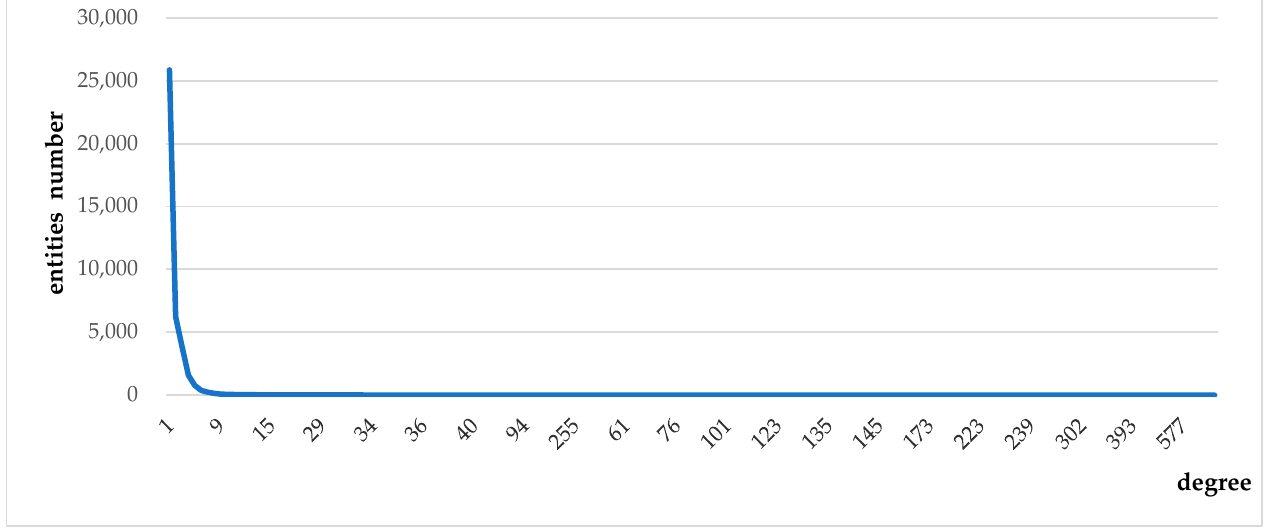
Figure 8. Distribution of entities with different degrees.